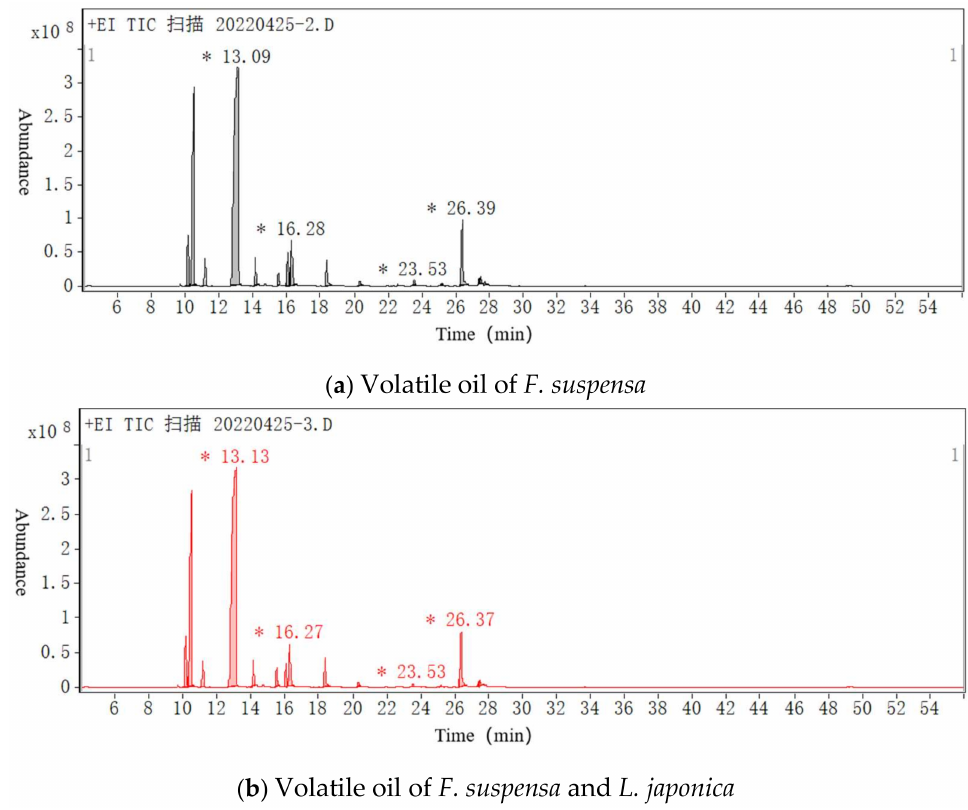
Figure 8. Total ion chromatogram of the GC–MS analysis of volatile oils. Table 10. The volatile oil of F. suspensa